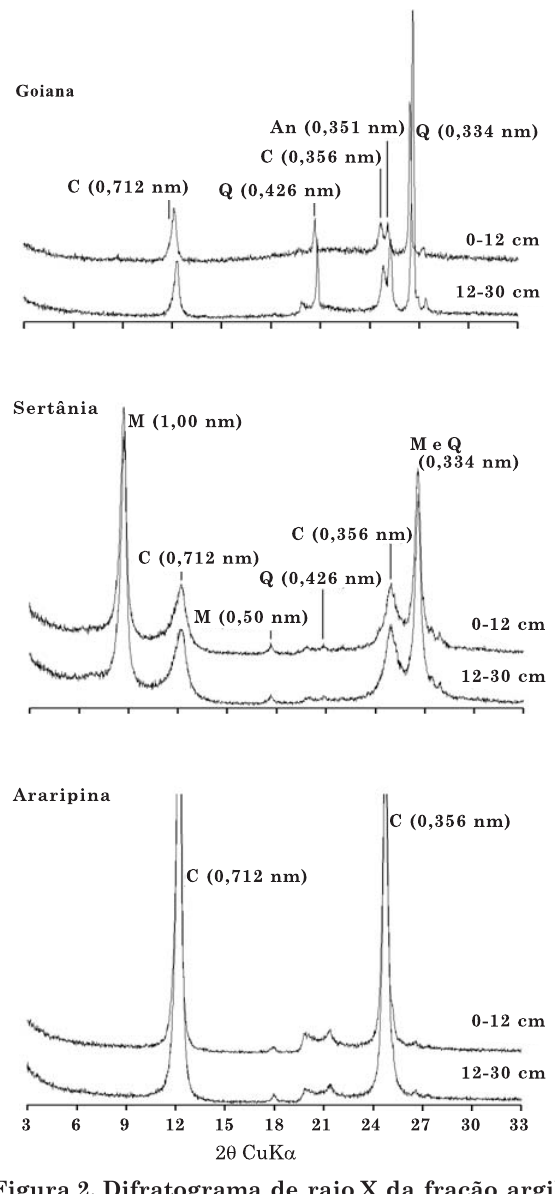
(b).Figura 2. Difratograma de raio X da fração argila saturada com K em temperatura ambiente. Q: quartzo, Na: anatásio, C: caulinita e M: